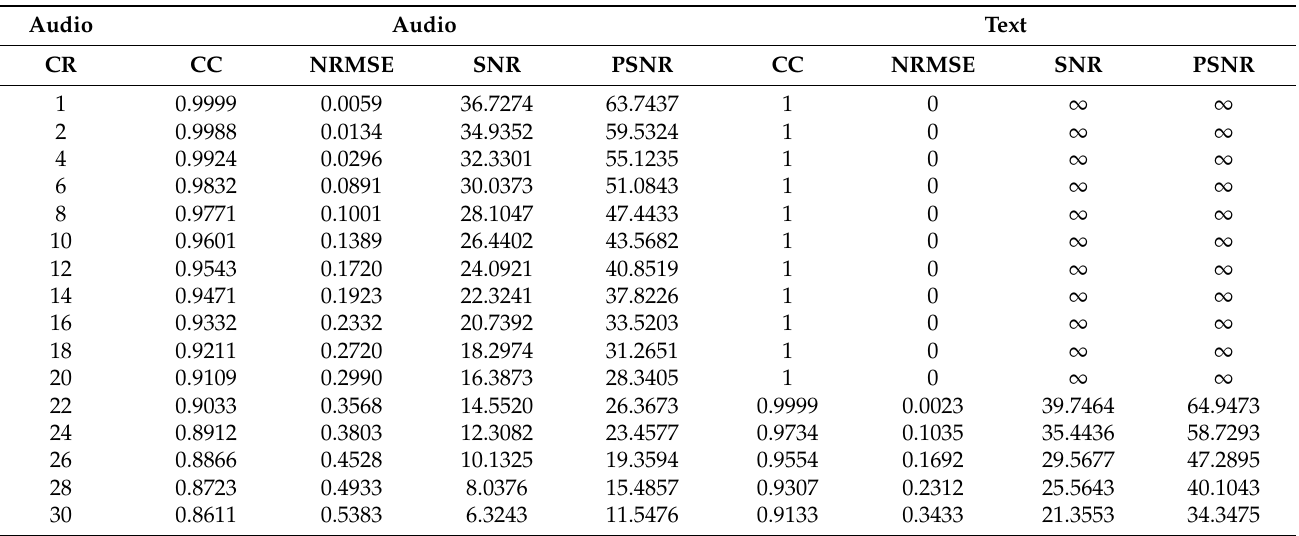
Figure 10. Recovered text information after 30-times compression of steganocoded audio signal (existing method). Table 2. The efficiency indicators of the stego-system based on the wavelet transform after the implementation of the developed